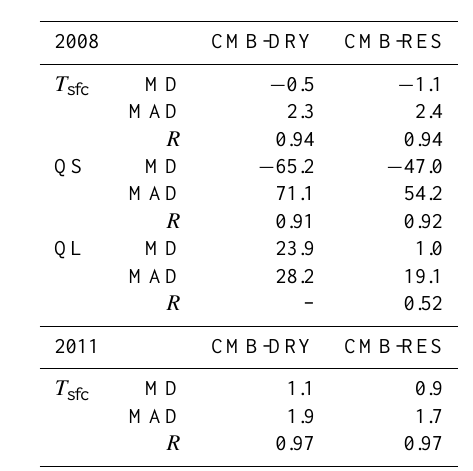
Table 3. Mean deviation (MD), mean absolute deviation (MAD), and R value for the evaluation variables of surface temperature ( T sfc ), and the turbulent fluxes of sensible (QS) and latent heat